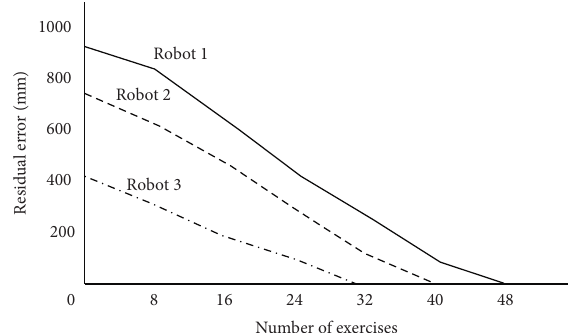
Figure 8: Control error test of the control method based on parallel rope traction.